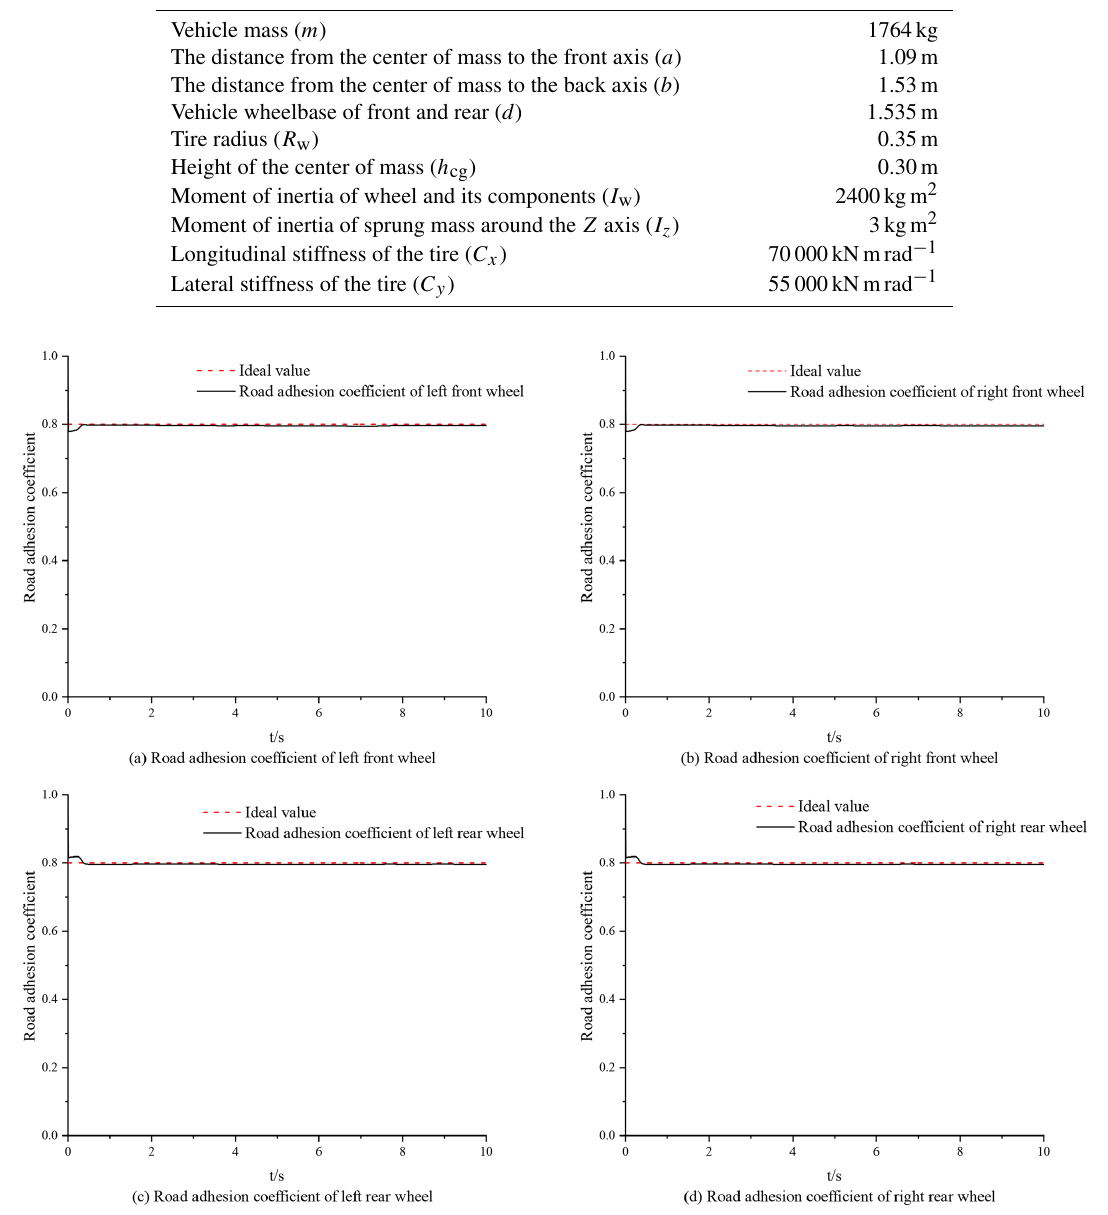
Figure 5. The high-adhesion road surface identification effect based on the UKF